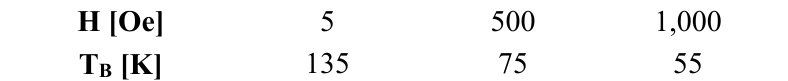
Table 6. Blocking temperatures for magnetic fields between 5 Oe and 1,000